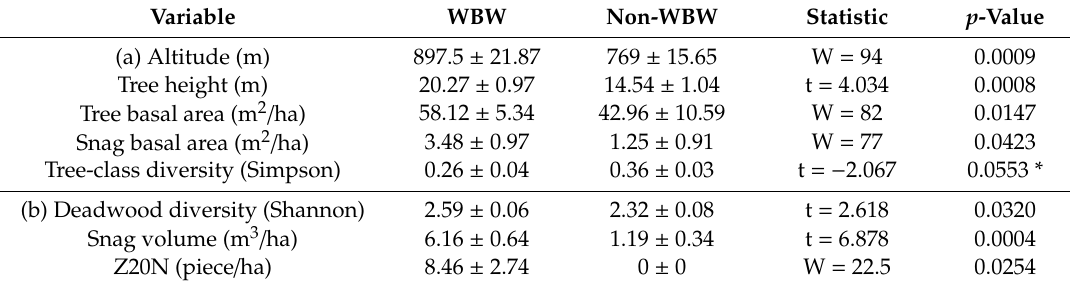
Table 1. Mean ± standard error, and p -value of the variables measured and calculated that showed significant di ff erences in white-backed woodpecker (WBW) territories and non-WBW territories in ( a ) the circular plots and, ( b ) the transects of 150–300 m length. “W” refers to the statistical value for the Wilcoxon–Mann–Whitney U-test and “t” for the t-test. Z20N = density of 20 cm diameter standing deadwood and in a state to be cut with a knife. * almost significant p